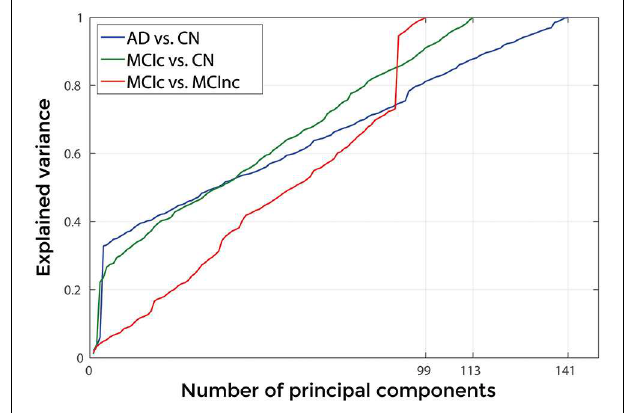
FIGURE 2 | PCA coefficients for the comparison between AD (o symbol) and CN ( × symbol) when using GM tissue probability map and